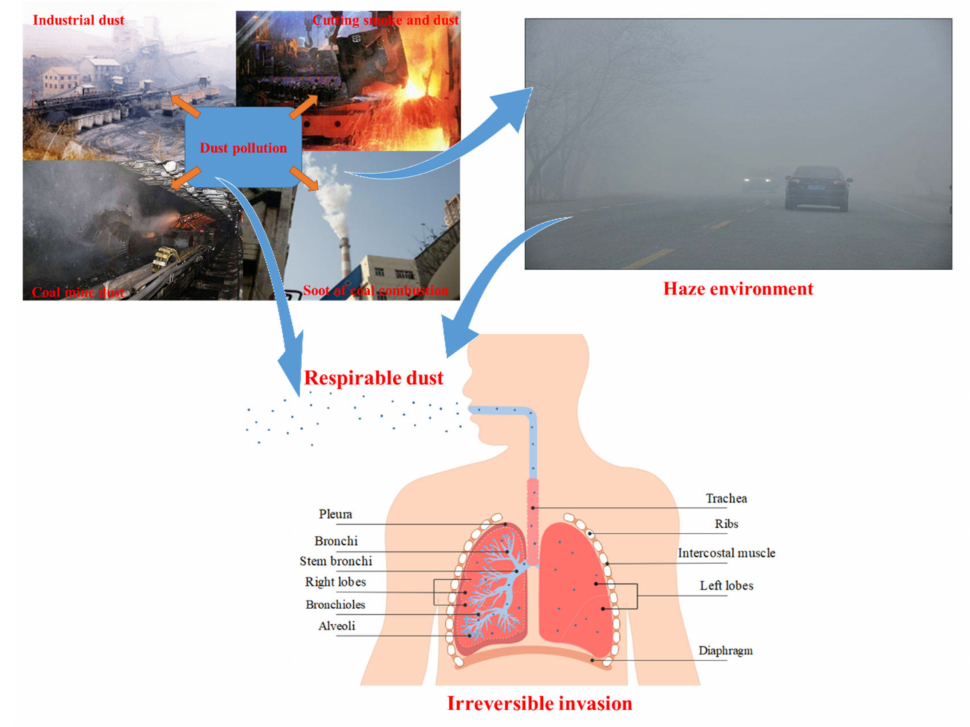
Figure 1. Influence of the improper small airborne particles from industrial activities on the environ- ment and human